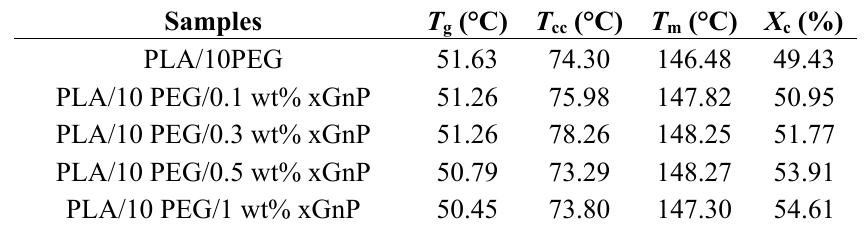
Table 1. Characteristic temperature and percentage of crystallinity of PLA/PEG and PLA/PEG/xGnP